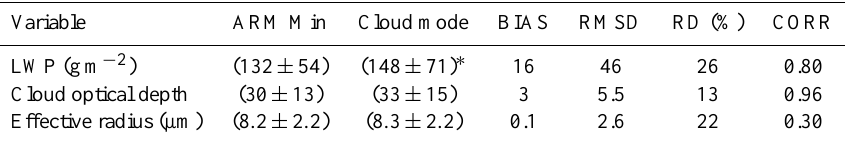
Table 5. Statistics for comparison of liquid water path, cloud optical depth and effective radius between the new cloud-mode retrievals and the ARM flux-based retrievals. Mean and standard deviation are included in each parenthesis. Cases are limited to non-precipitating and relatively homogeneous clouds during May 2007–June 2008.